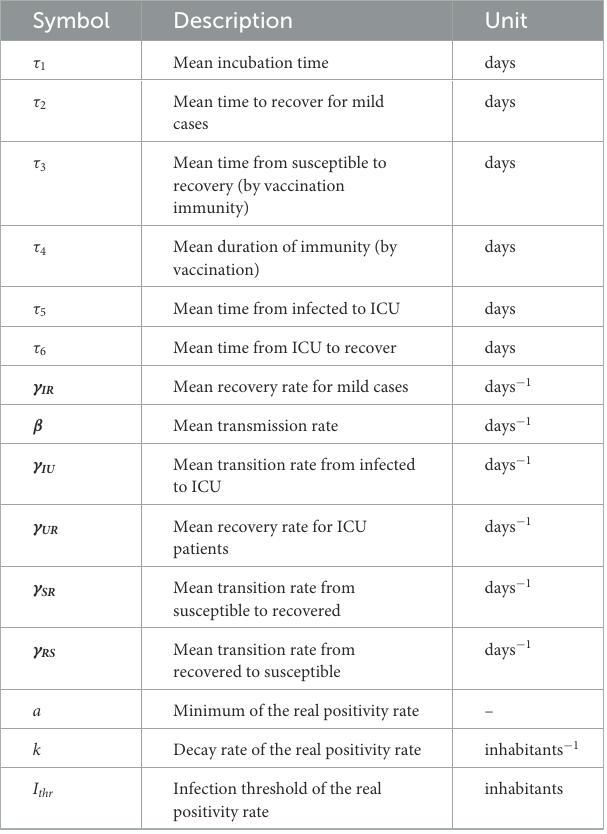
Table 1 Parameters of general epidemiological